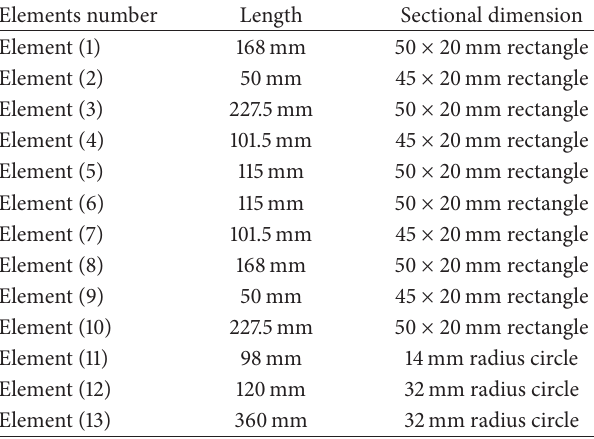
Table 1: Dimensions of beam elements for the computation